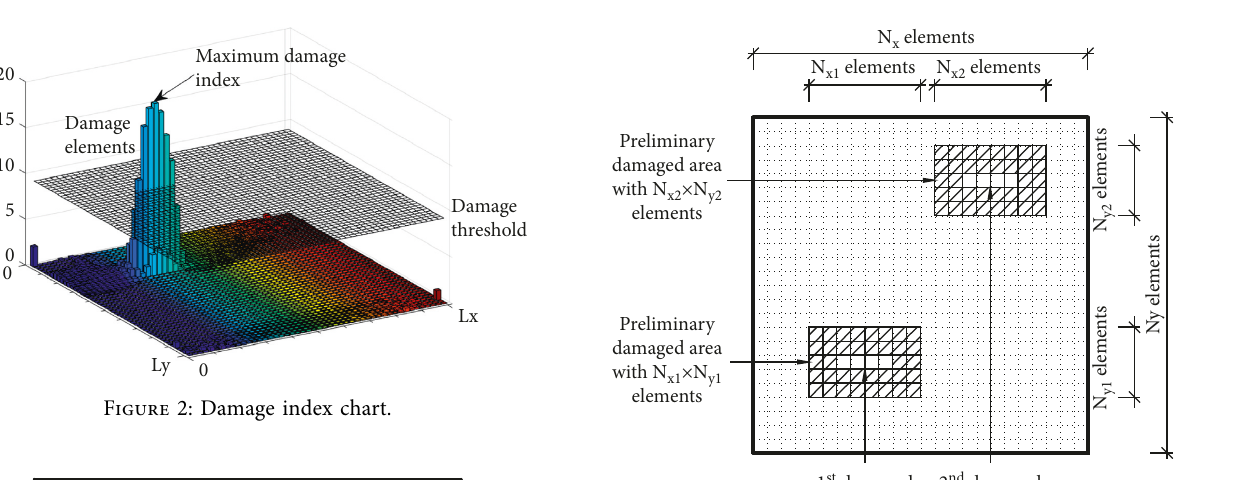
Figure 1: Illustration of a rectangular plate: (a) whole plate and (b) element ( i, j ) .